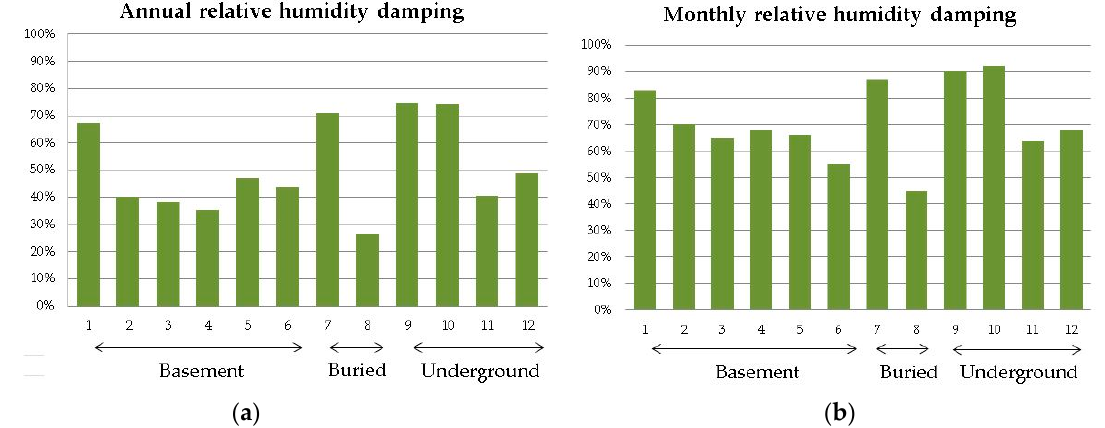
Figure 8. Damping of relative humidity in buildings analyzed ( a ) Annual relative humidity damping; ( b ) Monthly relative humidity damping. Table 2. Representative values of the relative humidity inside each of the monitored aging